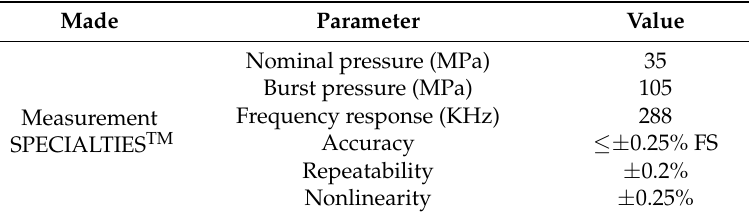
Table 2. The main parameters of pressure transducer of XPM 10.